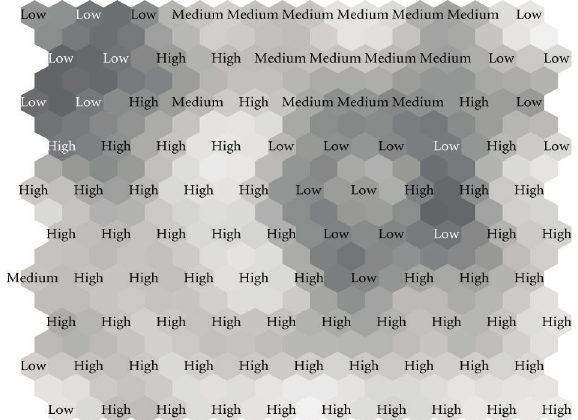
Figure 11: The U-matrix for the feature Integrity